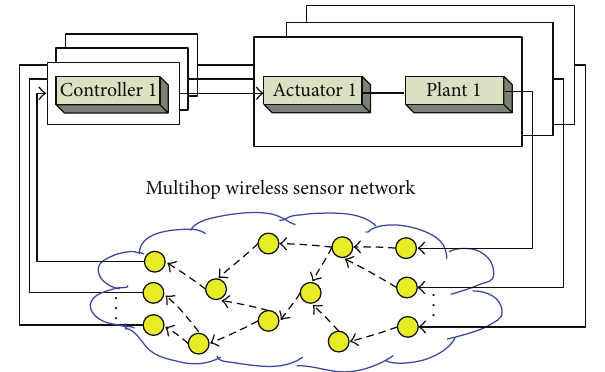
Figure 1: A wireless multihop sensor network.